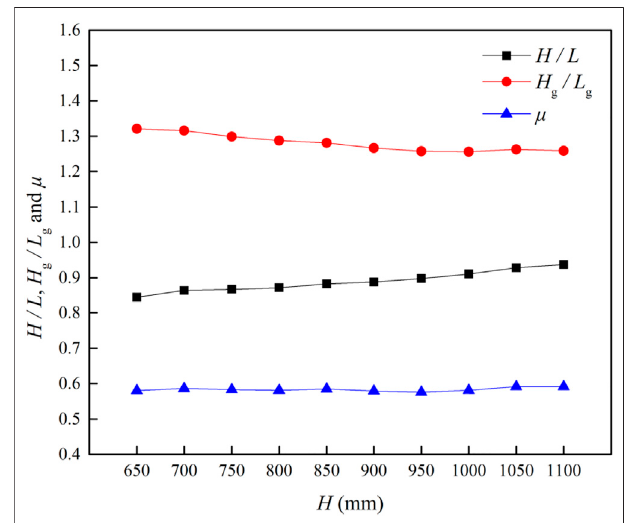
FIGURE 10 | Variations in H/L , H g /L g , and μ with H